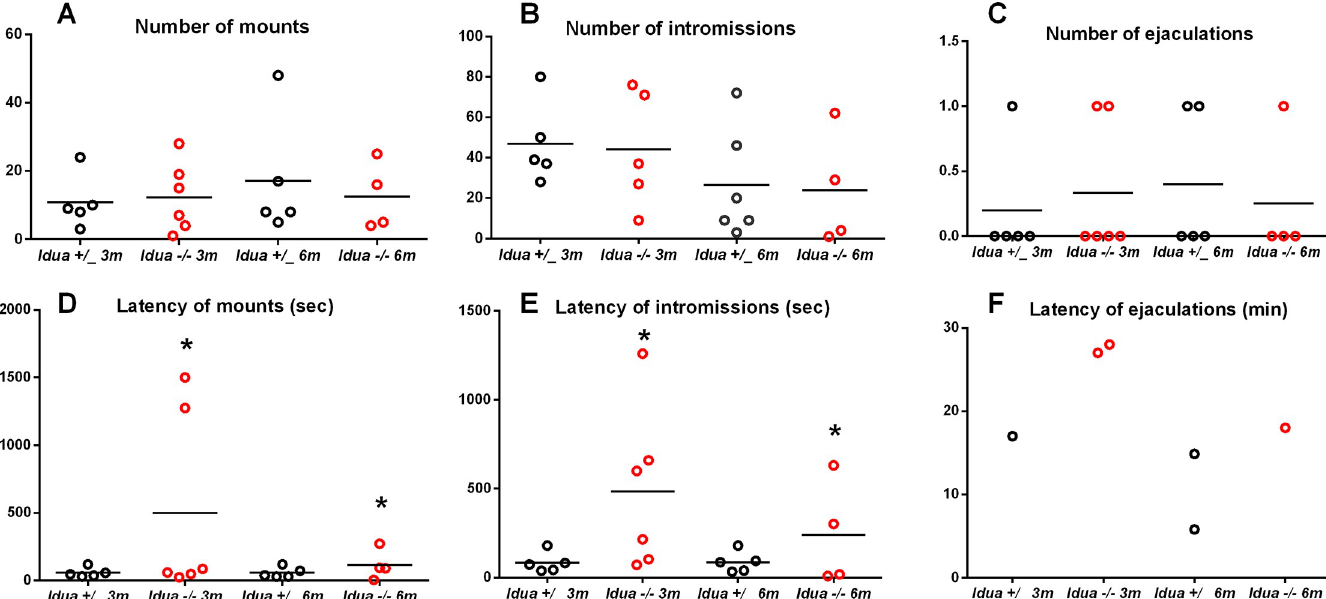
Fig 1. Analysis of male sexual behaviour. (A-C) Frequency of male copulatory behaviours (mount, intromission and ejaculation). (D-F) Latency of male copulatory behaviours (mount, intromission and ejaculation). Idua +/_ and Idua -/- mice were previously adapted to mating and exposed to oestrous-induced females. In males, tests were performed in two different time points of MPS I progression: 3 and 6 months of age. The experiment was performed under dim-red light, for 30 minutes Statistical analysis: generalized estimating equations. � p < 0.05 compared to control group.